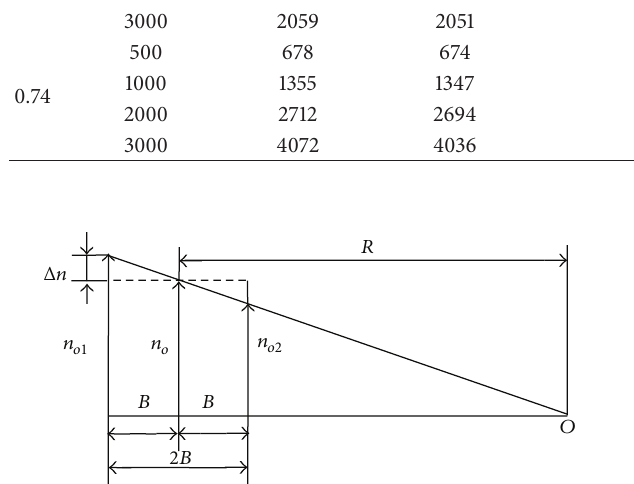
Figure 11: Speed relationship of inverse differential gearbox in